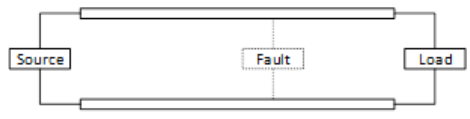
Figure 23. Schematic of the fault